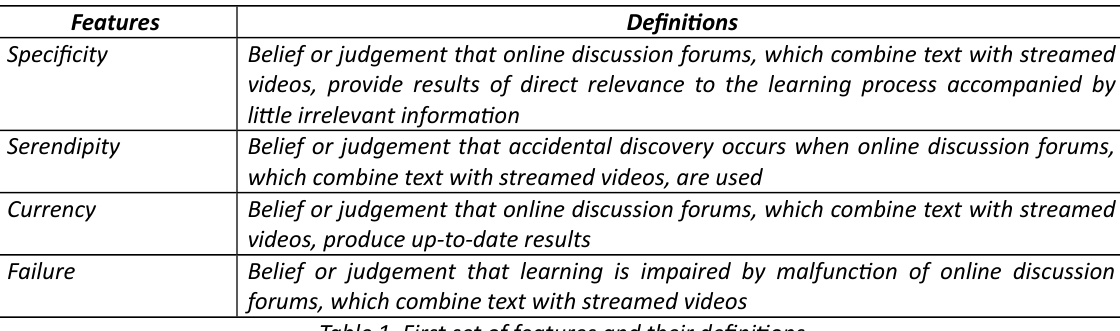
Table 1. First set of features and their defnitons